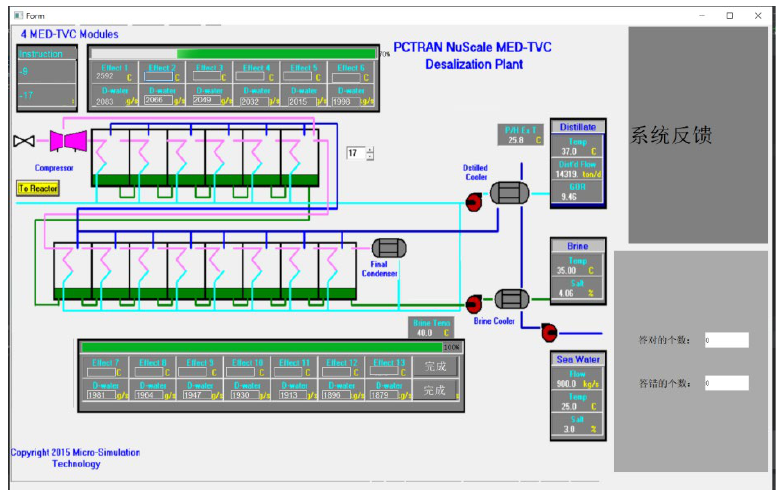
Figure 3. Interface of Mental Arithmetic Task.